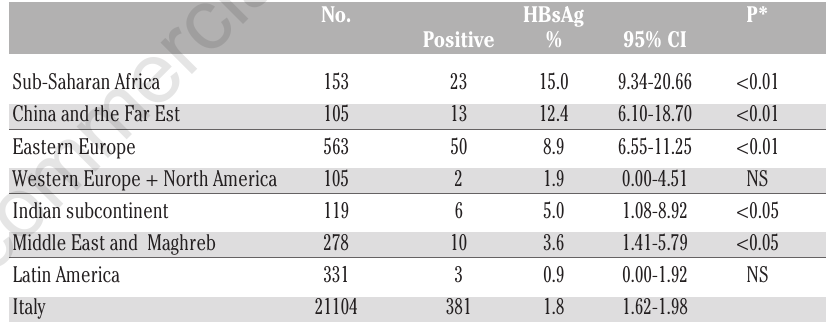
Table 2. Hepatitis B surface antigen (HBsAg) seropositivity by geographical origin (2007- 2008).